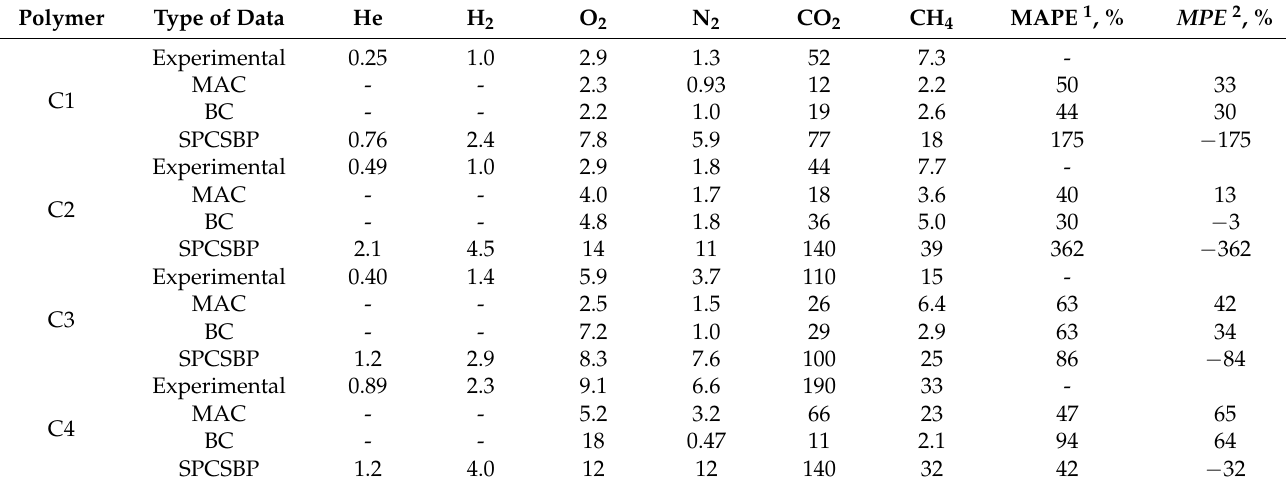
Table 9. Experimental gas solubility coefficients S · 10 3 (cm 3 (STP) · cm − 3 · cmHg − 1 ) in synthesized polymers at 35 ◦ C and predicted data for the same polymers. Polymer Type of